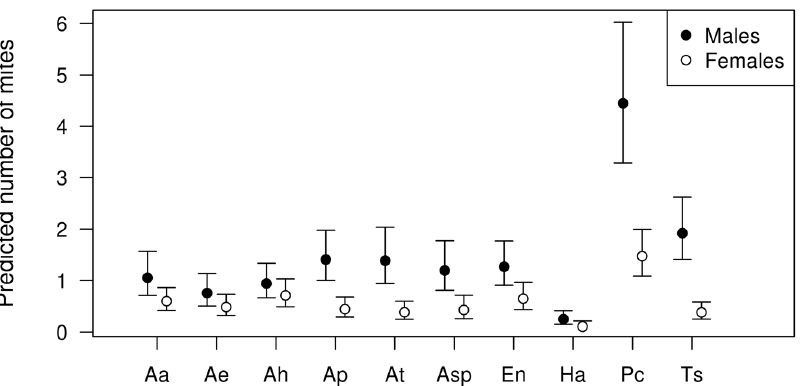
Figure 3. Sex biases in parasitism: observational mite data. Predicted mite abundance for the observational study according to sex and species interaction. Codes for species identity: Aa= Argia anceps , Ae= A. extranea , Ah= A. harknessi , Ap= A. pulla , At= Argia tezpi , Asp= Argia sp. , En= Enallagma novahispaniae , Ha= Hetaerina americana , Pc= Protoneura cara , Ts= Telebasis salva . Error bars depict 95% confidence intervals.